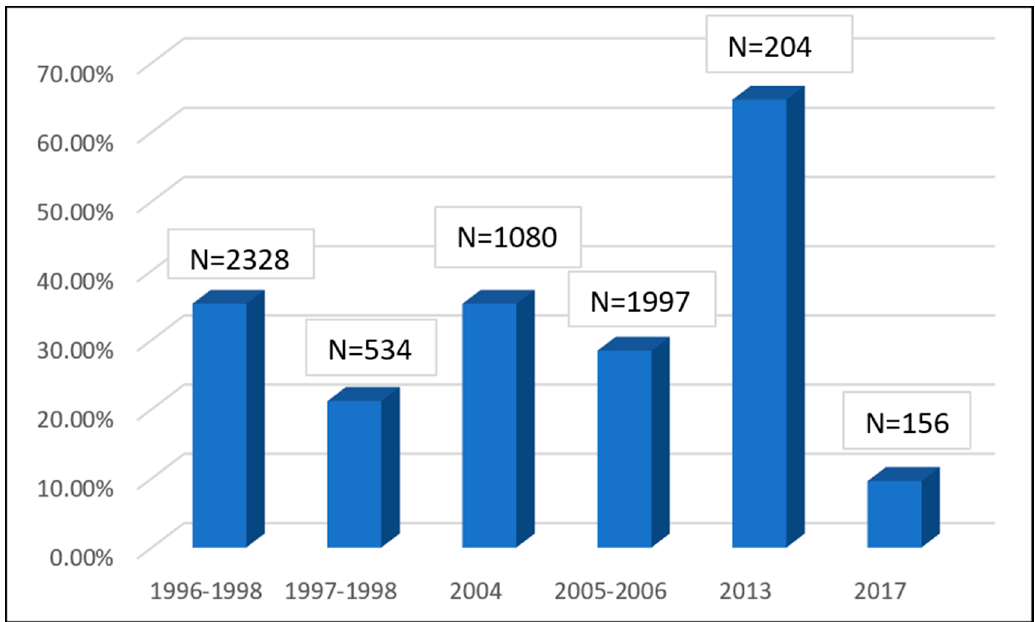
Figure 2. Prevalence of antibodies against hepatitis B core antigen (anti-HBc) among healthy populations in Bangladesh.